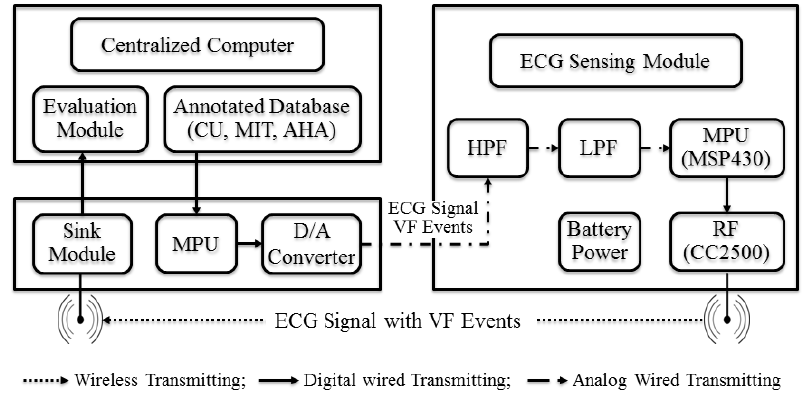
Figure 8. Block diagram of the testing environment.